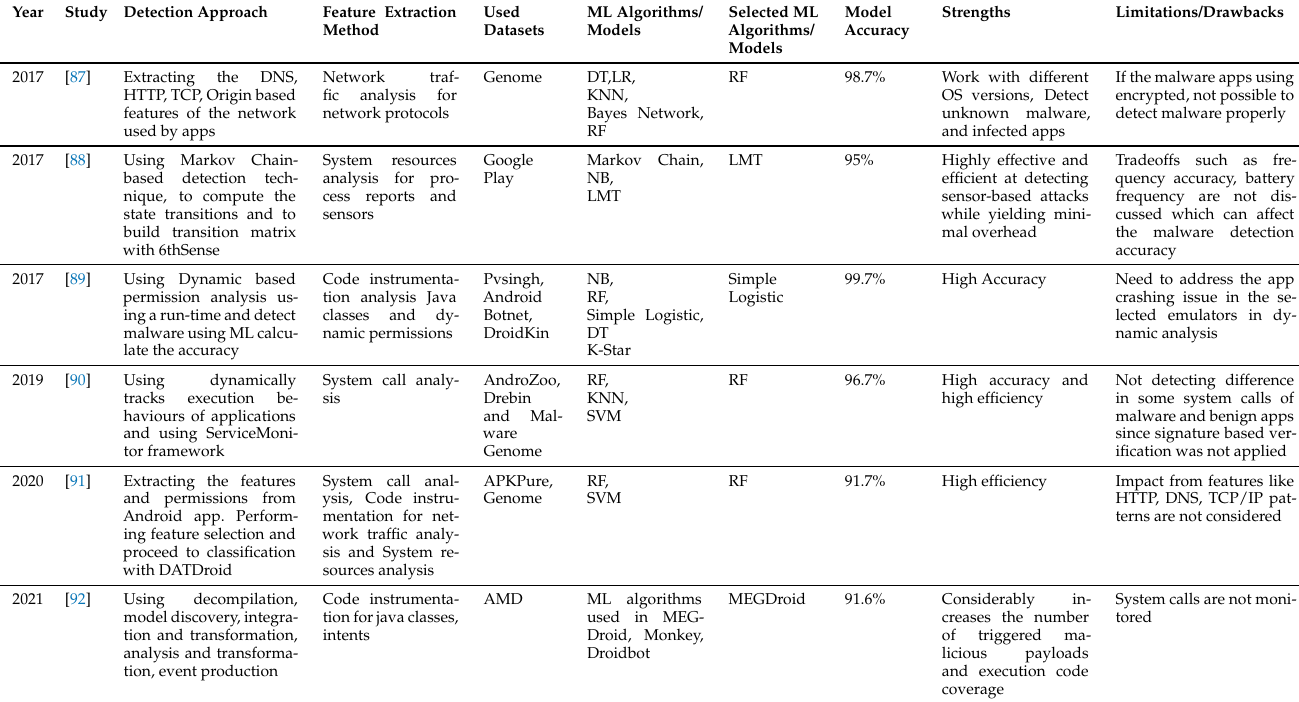
Table 5. Dynamic analysis based malware detection